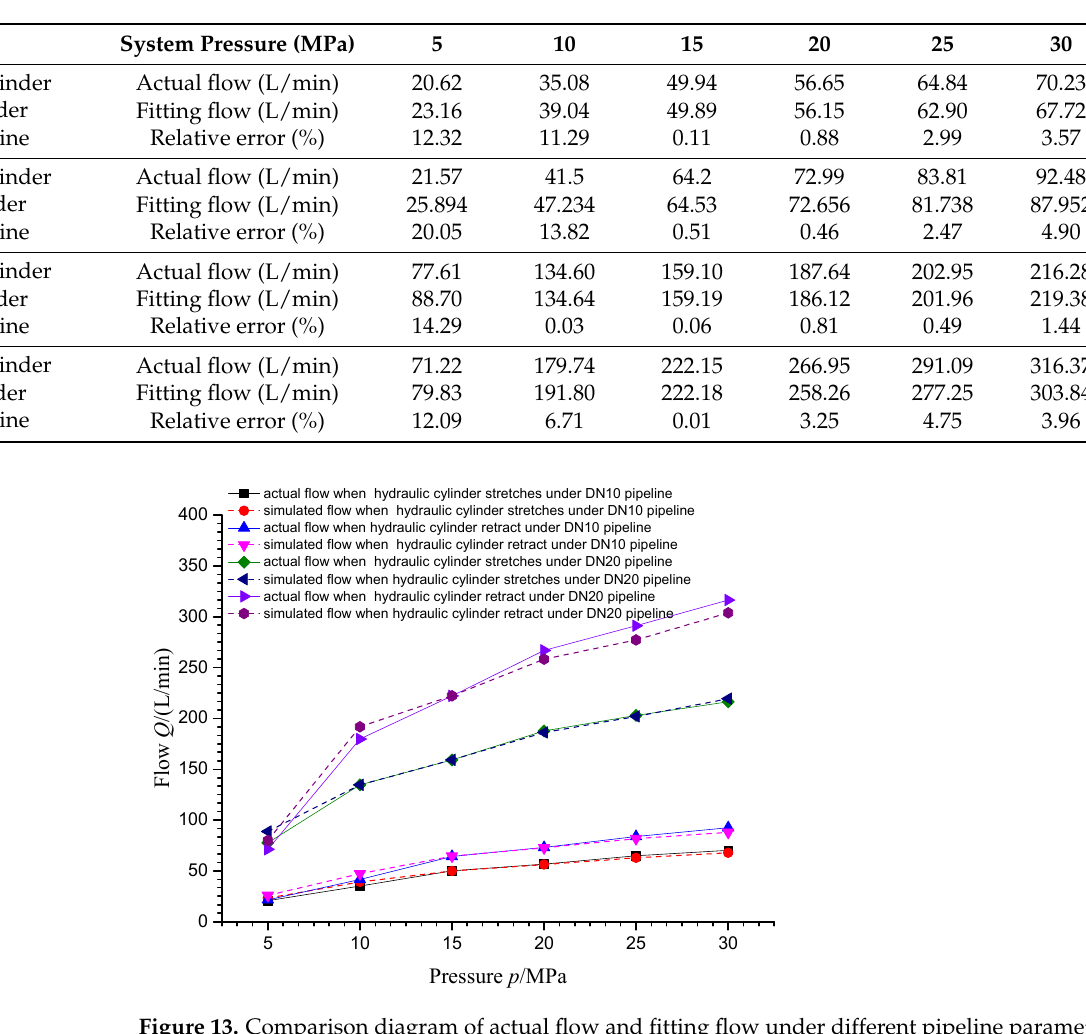
Table 8. Comparison table of fitting flow and measured flow under different pipeline diameters.